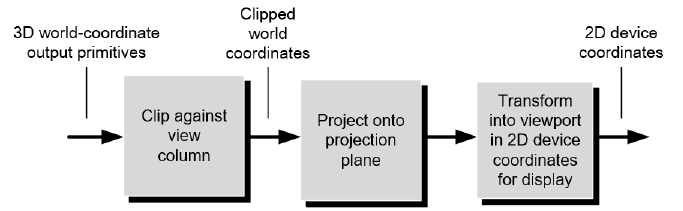
Figure 6. Conceptual model of the three-dimensional viewing